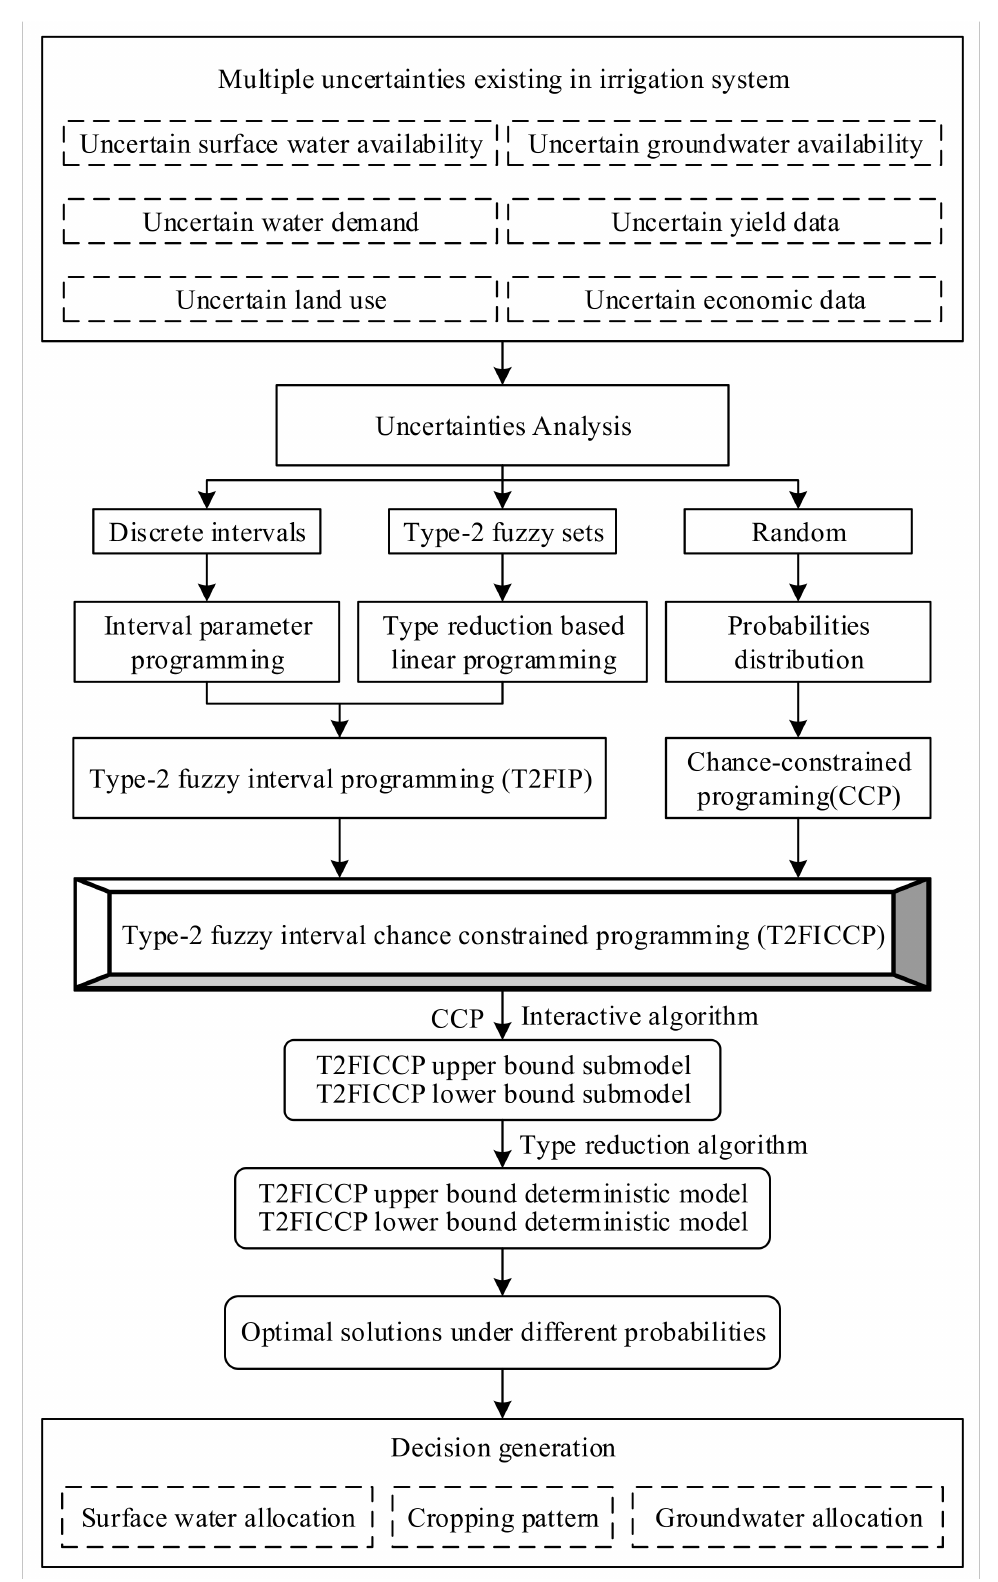
Figure 2. The research process of this